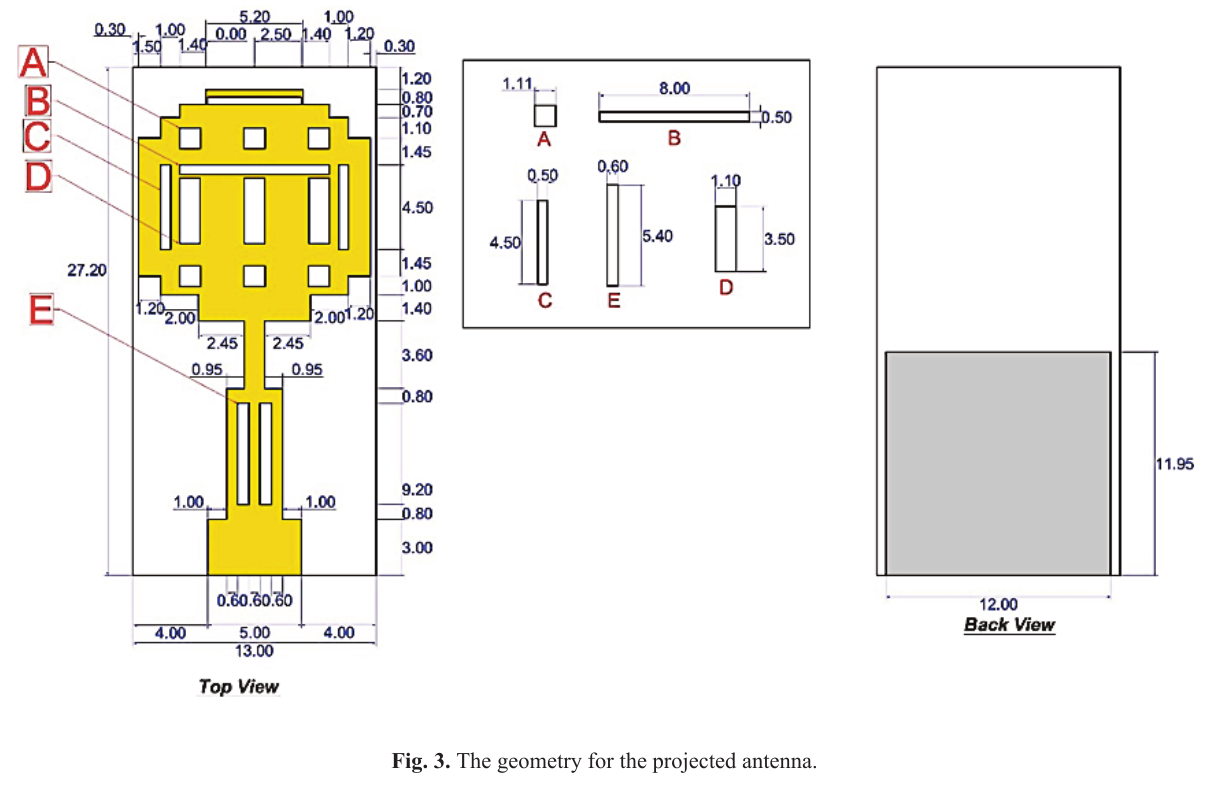
Fig. 3. The geometry for the projected antenna.